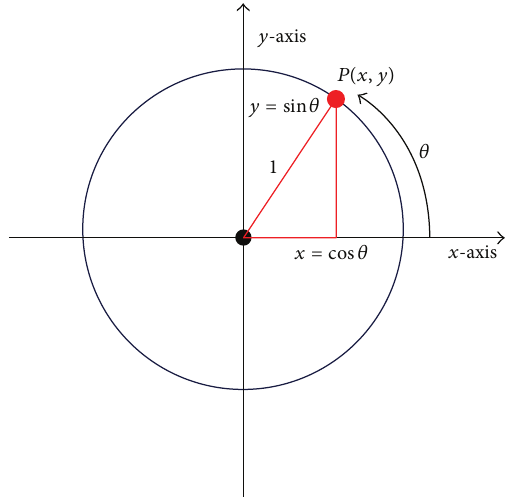
Figure 6: Perception points on the unit